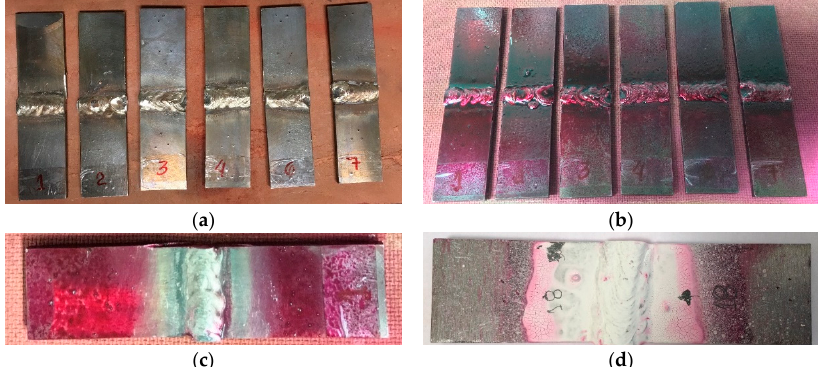
Figure 6. Penetrating dye test procedure: ( a ) sample cleaning with solvent agent; ( b ) application of penetrating dye spray; ( c ) cleaning of excess penetrating dye from sample surface; and ( d ) sample with revealer applied to surface.